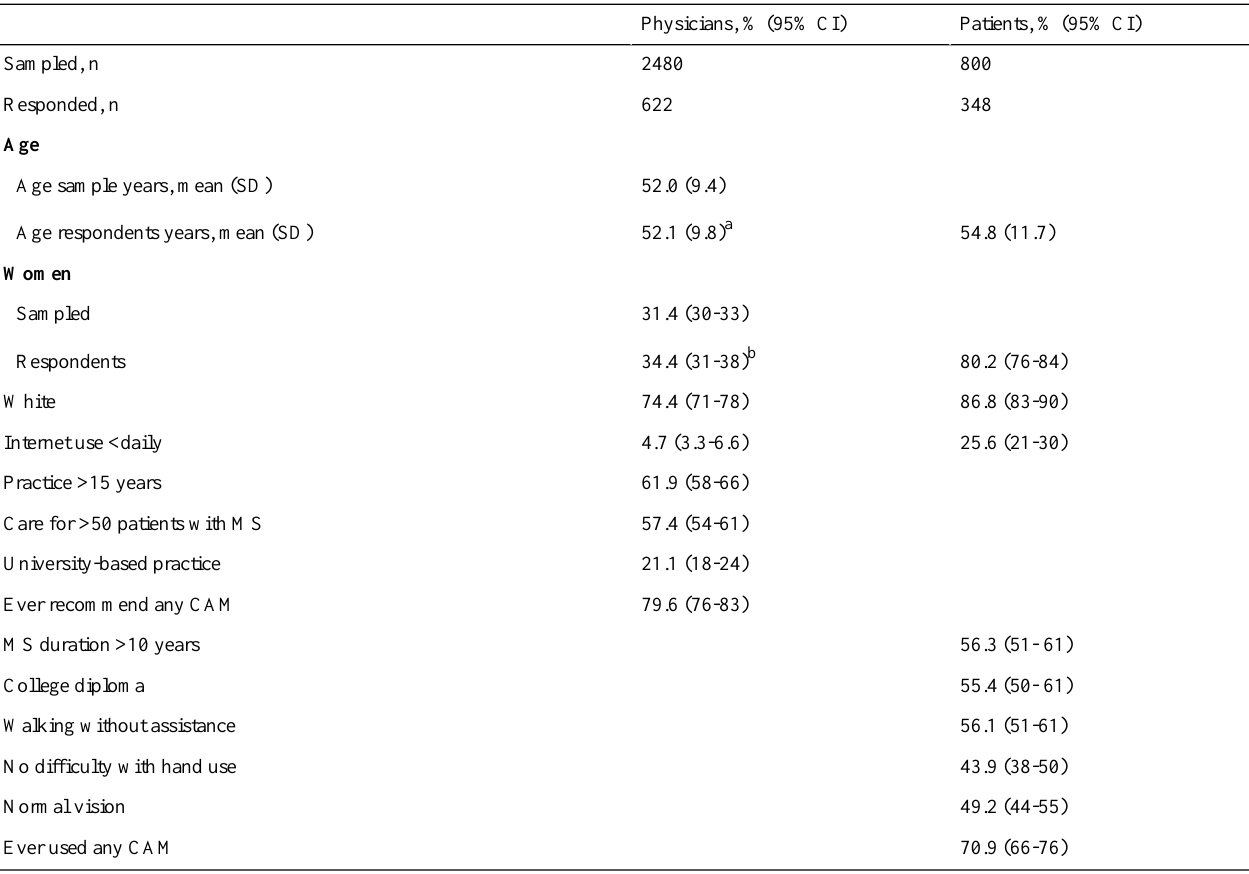
Table 1. Characteristics of surveyed patients and physician (95% confidence interval rounded to nearest whole